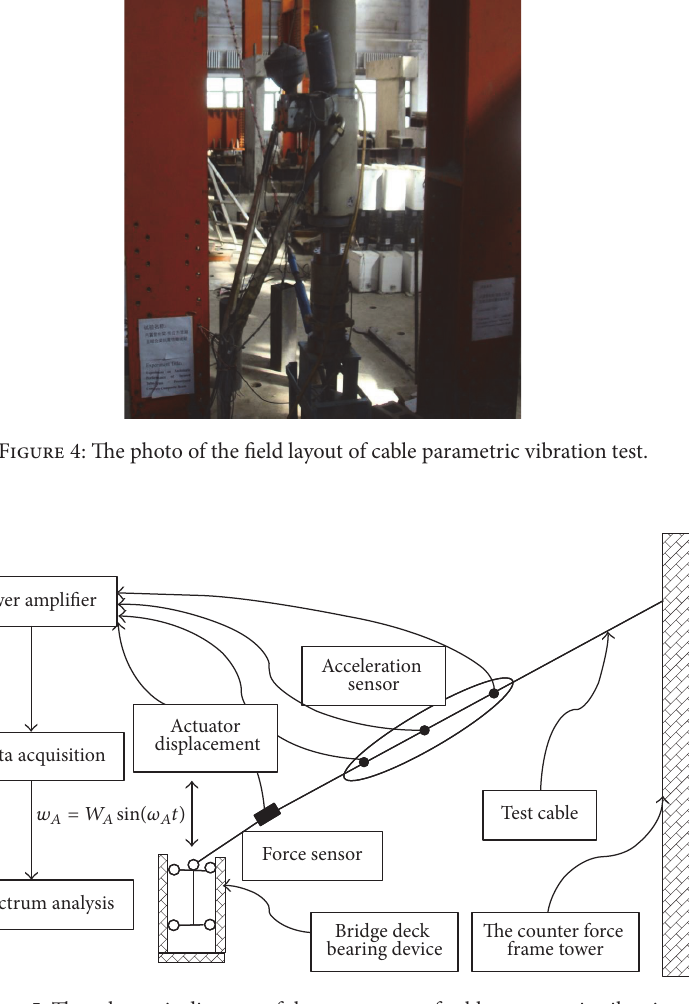
Figure 5: The schematic diagram of the test system of cable parametric